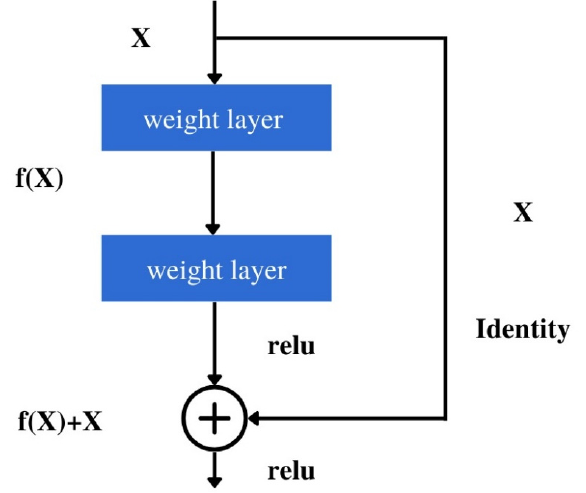
Figure 2. Basic Structure of DRN.